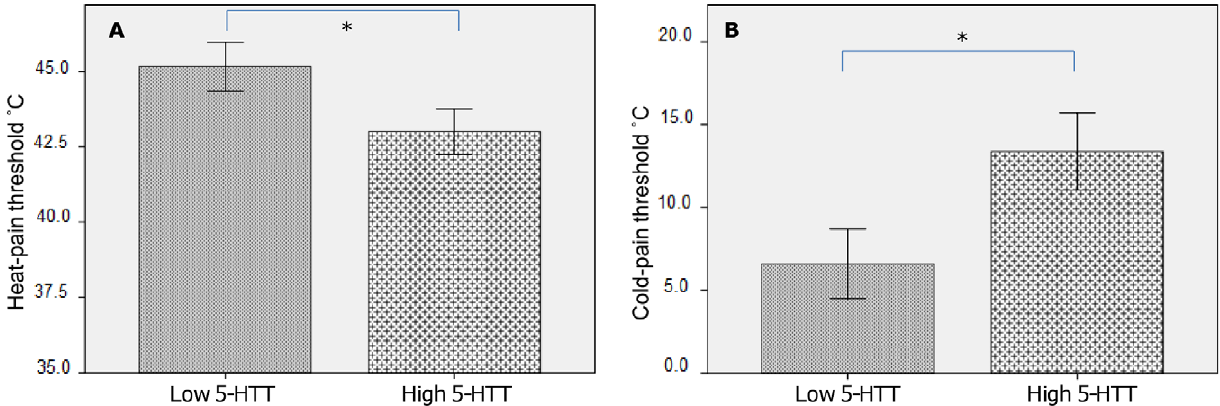
Figure 2. Thermal pain thresholds. A) Heat-pain thresholds. The difference between average heat-pain threshold for the high- versus the low 5- HTT-expressing groups was significant [U=155.0, z= 2 2.03, p=0.02, one-tailed test]. B) Cold-pain thresholds. The difference between average cold- pain threshold for the high versus the low 5-HTT-expressing groups was significant [U=162.0, z= 2 1.91, p=0.03, one-tailed test].